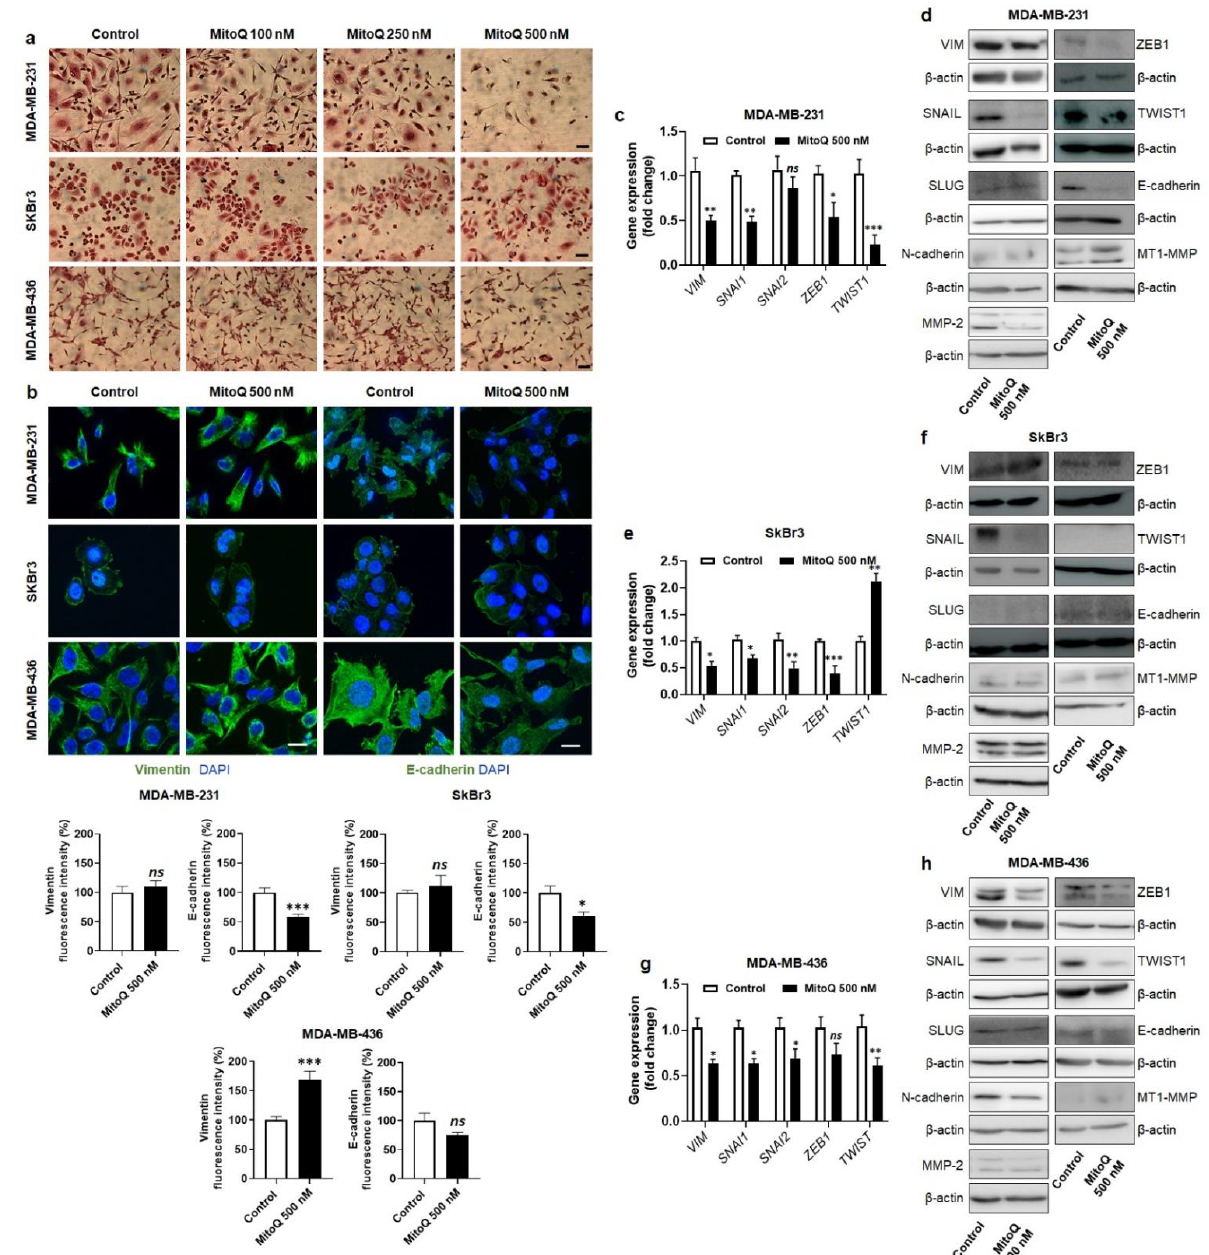
Figure 4. MitoQ has mitigated effects on the epithelial to mesenchymal transition (EMT) of human breast cancer cells. Cells were treated ± MitoQ for 48 h. ( a ) Representative immunocytological pictures where MDA-MB-231, SkBr3 and MDA-MB-436 cells are stained with hematoxylin and eosin. Bars = 1 mm. ( b ) Cells were stained with primary antibodies anti-vimentin and anti-E-cadherin (green fluorescence), and nuclei were stained with DAPI (blue). Representative pictures are shown on top, and the graphs on the bottom show the fluorescence intensity for MDA-MB-231 ( n = 9–12), SkBr3 ( n = 9–12) and MDA-MB-436 ( n = 11-12) cells. Bars = 20 µm. ( c ) mRNA expression of EMT markers vimentin ( VIM ), SNAIL ( SNAI1 ), SLUG ( SNAI2 ), ZEB1 and TWIST1 in MDA-MB-231 cancer cells treated ± 500 nM MitoQ for 48 h ( n = 6–9). ( d ) Western blots (WBs) of the corresponding proteins with β-actin as a loading control. ( e ) mRNA expression in c, but in SkBr3 cells ( n = 3–9). ( f ) WBs as in d, but using SkBr3 cells. ( g ) mRNA expression in c, but in MDA-MB-436 cells ( n = 6–9). ( h ) WBs as in d, but using MDA-MB-436 cells. All data are shown as means ± SEM. * p < 0.05, ** p < 0.01, *** p < 0.001 compared to control; ns : p > 0.05 compared to control; by Student t test ( b , c , e , g